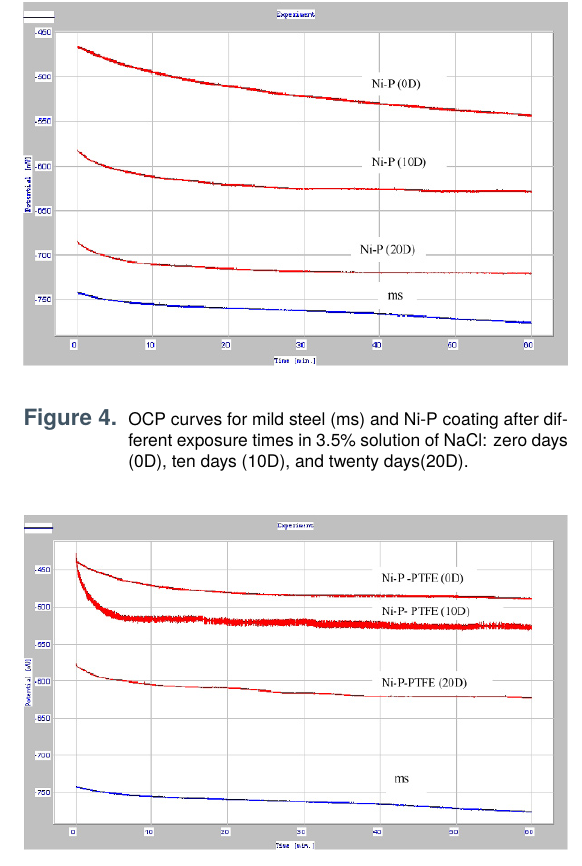
Parameters drawn from these curves are shown in Table